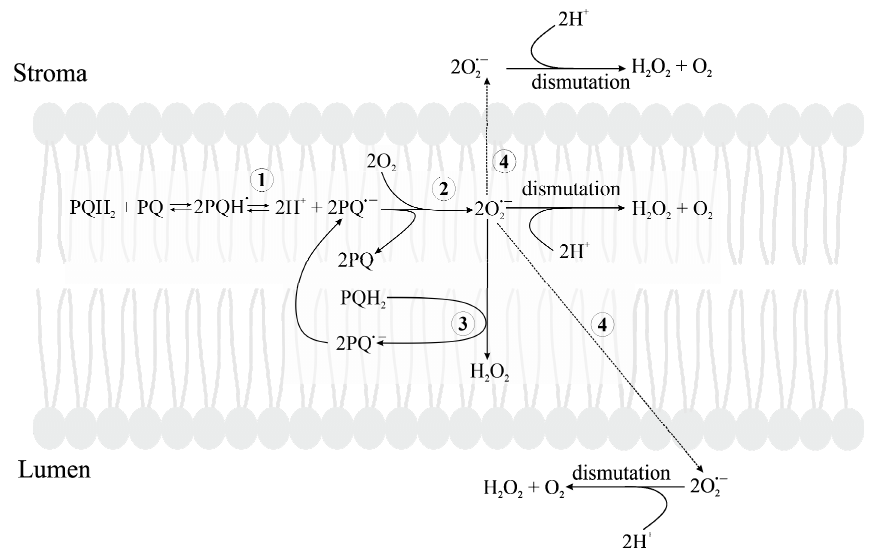
Figure 4. Autocatalytic oxidation of reduced plastoquinone (PQH 2 ) by O 2 in the thylakoid membrane.